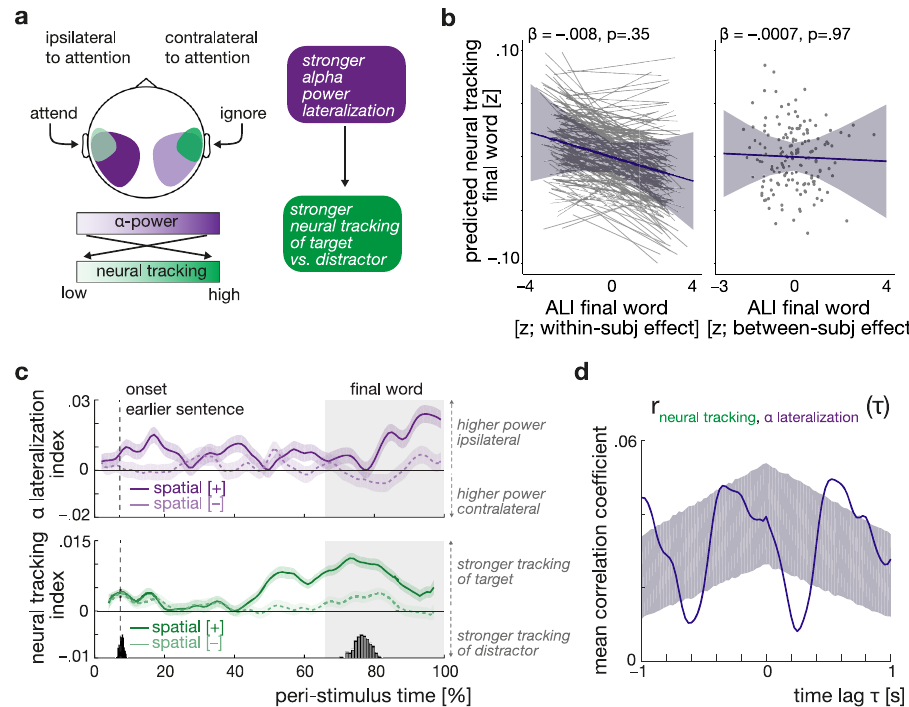
Fig. 5 Relationship of alpha lateralization and neural speech tracking. a Hypothesized relationship of alpha power and neural speech tracking within the auditory region of interest. Changes in alpha lateralization are assumed to drive changes in neural tracking. Schematic representation for an attend-left trial. b Independence of neural speech tracking and alpha lateralization during fi nal-word presentation as shown by the predictions from the same linear mixed- effect model. Plots show the predicted, non-signi fi cant effect of within- and between-subject variations in alpha lateralization on selective neural tracking, respectively. Blue lines indicate the respective predicted fi xed effects with 95% con fi dence interval, grey thin lines in the left plot show N = 155 subject- speci fi c random slopes (included for illustrative purposes only), and grey dots show average predictions per subject. β : slope parameter estimate from the corresponding general linear mixed-effects model, two-sided Wald test (FDR-corrected). c Grand-average time courses of alpha lateralization and neural speech tracking during sentence presentation mapped to the same peri-stimulus time axis. Shown separately for selective attention (darker, solid curves) and divided-attention trials (lighter, dashed curves). Error bands re fl ect ±1 SEM. Note how the peak in neural speech tracking under selective attention precedes the peak in alpha lateralization. d Mean normalized cross-correlation of trial-averaged neural speech tracking and alpha lateralization time courses. The upper and lower bound of the shaded areas re fl ect the 97.5th and 2.5th percentile of surrogate data derived from 5000 independently permuted time courses of alpha power and neural speech tracking. Source data are provided as a Source Data fi